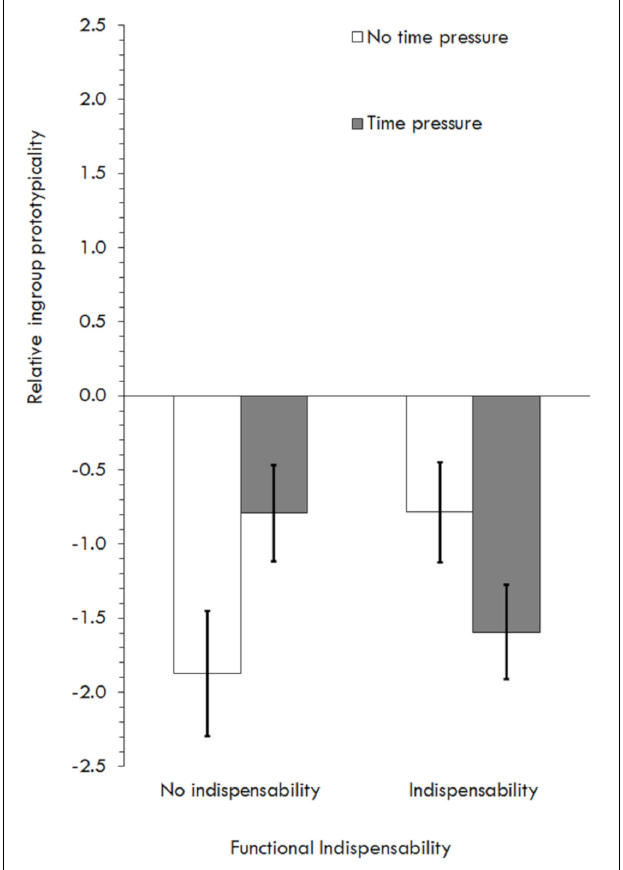
FIGURE 2 | Effects of relative ingroup prototypicality depending on functional indispensability and information processing in Study